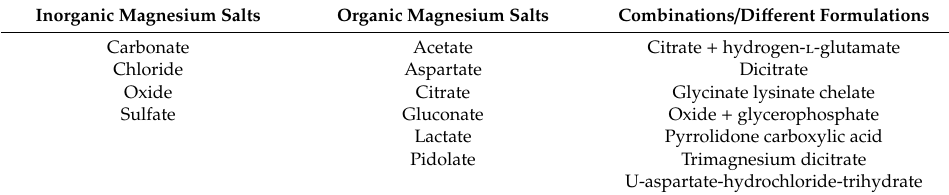
Table 1. Inorganic and organic salts used for magnesium supplementation